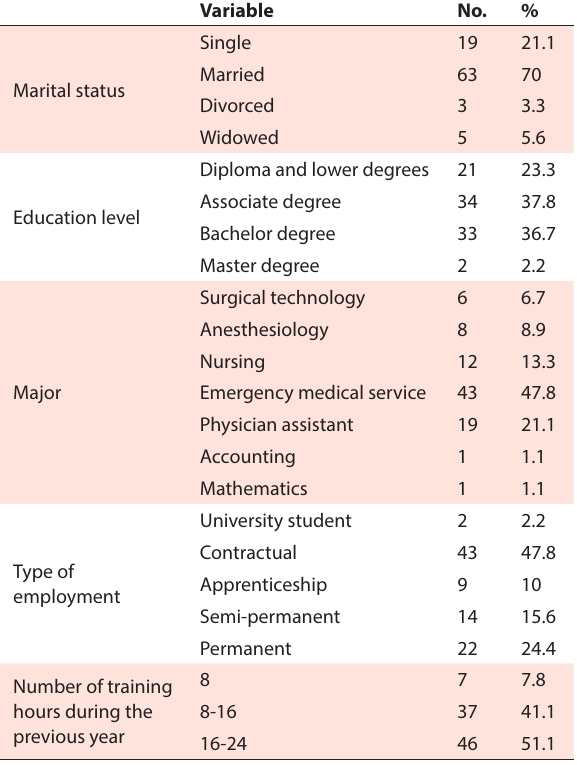
Table 1. Frequency of demographic variables in the emergency personnel of Rasht Variable